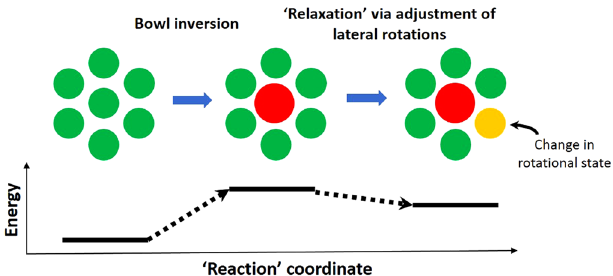
Fig. 7 Schematics of the proposed reaction path for bowl inversion and its effect on the neighboring molecules. In the fi rst stage, the inversion of the bowl-up ( green circle ) to bowl-down ( large red circle ) state elevates the energy of the system. In the second stage, the system gets relaxed by adjusting the rotational state of nearby molecule (shown by orange circle